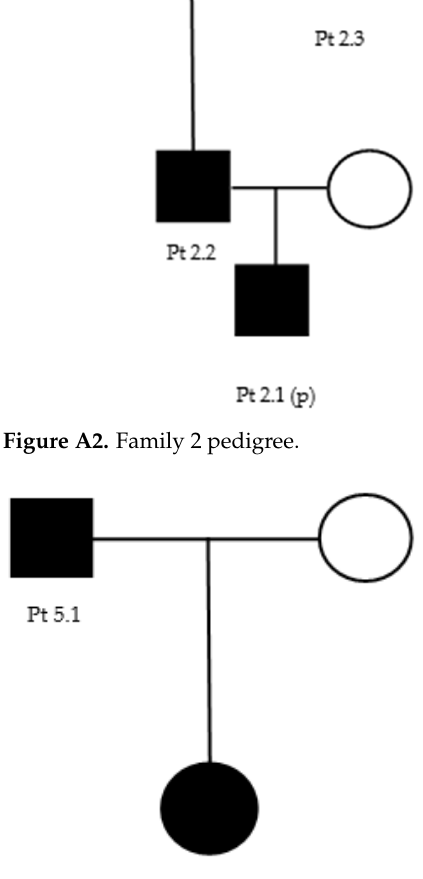
Figure A4. Family 6 pedigree. References 1.